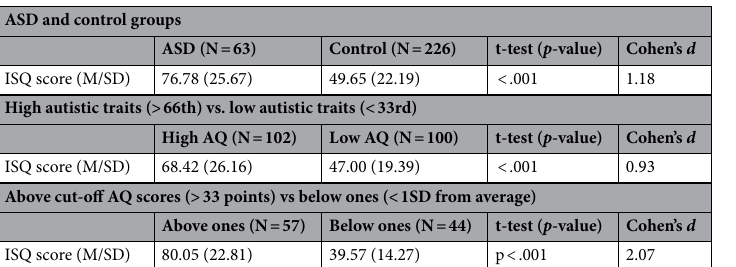
Above cut-off AQ scores (> 33 points) vs below ones (< 1SD from average) Above ones (N = 57) Below ones (N = 44) t-test ( p -value) Cohen’s d ISQ score Table 5. Differences in ISQ scores between ASD and control groups, high vs low autistic traits groups, and above cut-off AQ scores vs below ones.